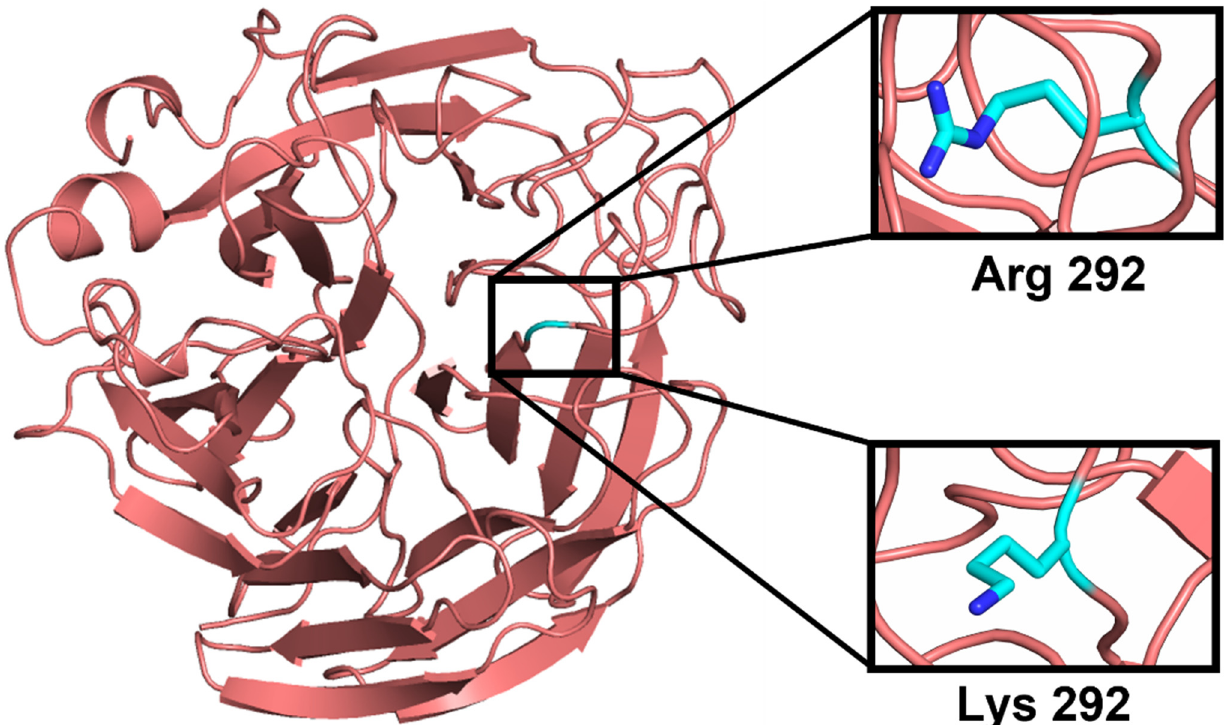
Figure 2. Representation of the R292K point mutation displaying the atomic Arginine and Lysine at residue number 292.